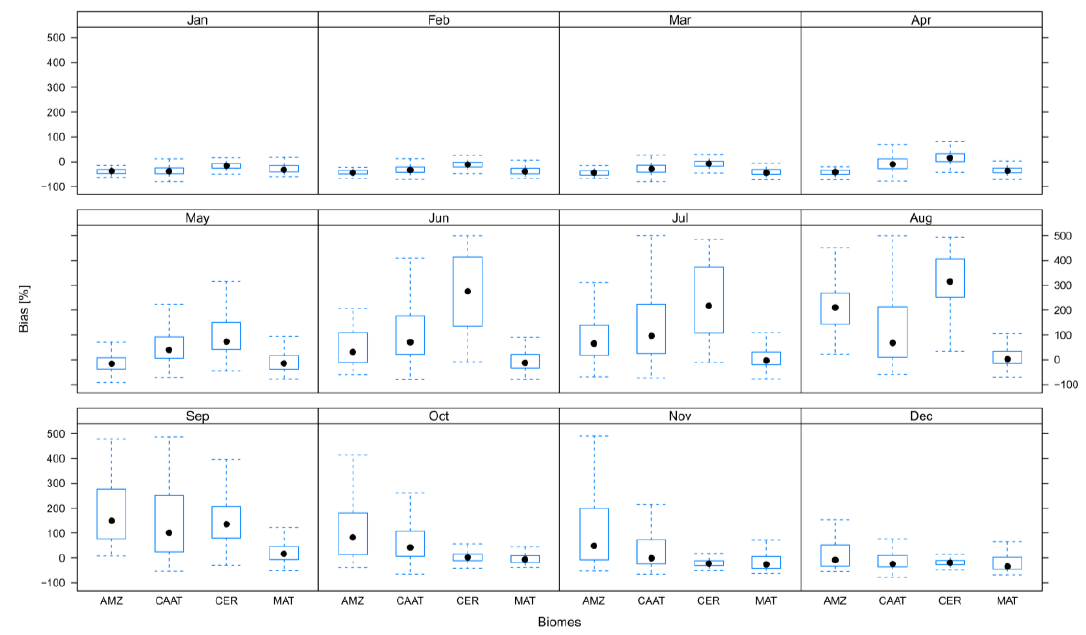
Figure 8. As per Figure 7, but for the percent bias. The components of a boxplot are described in Figure 5.